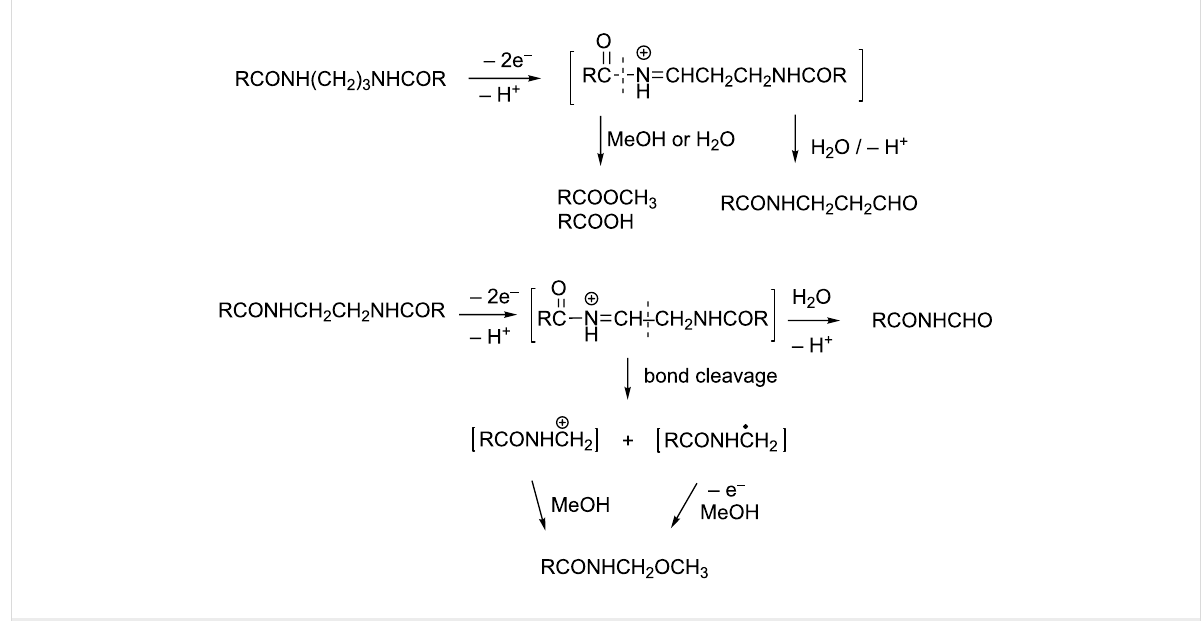
Scheme 12: Mechanisms of formation of fragmentation products.